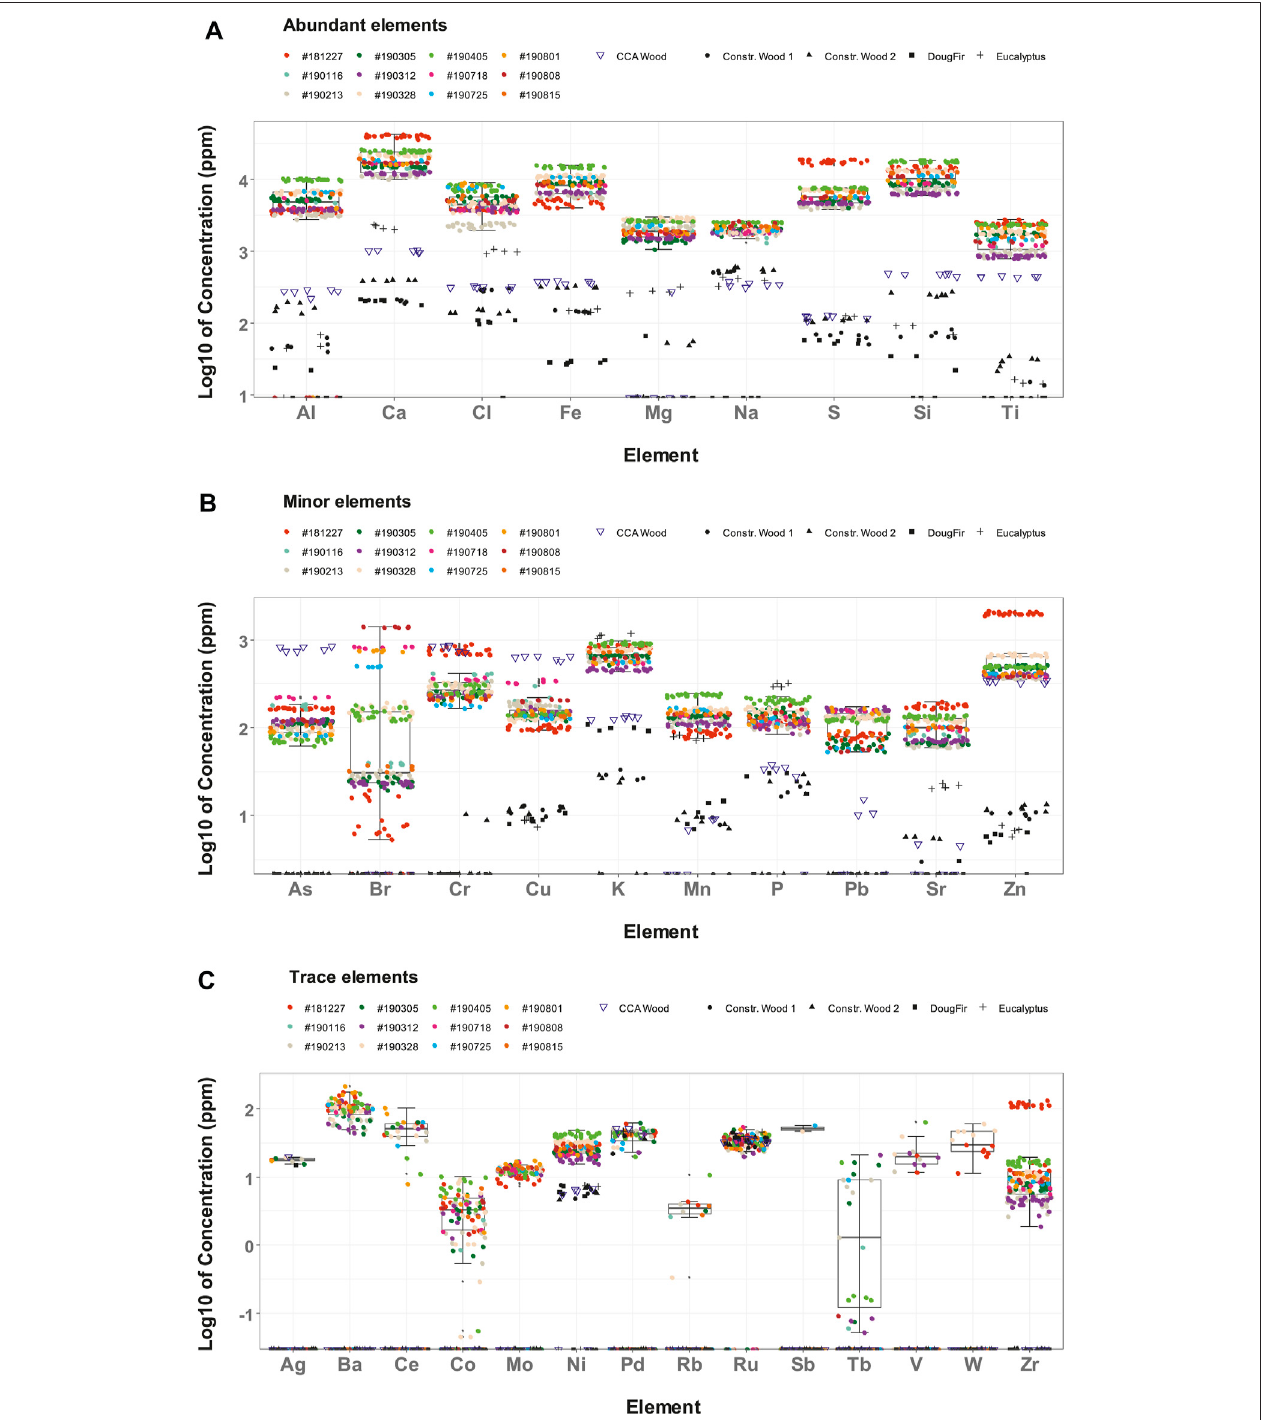
FIGURE 6 | Concentration of elements from individual measurements in CCDWDF materials and reference woods for (A) abundant elements, (B) minor elements, and (C) trace elements.